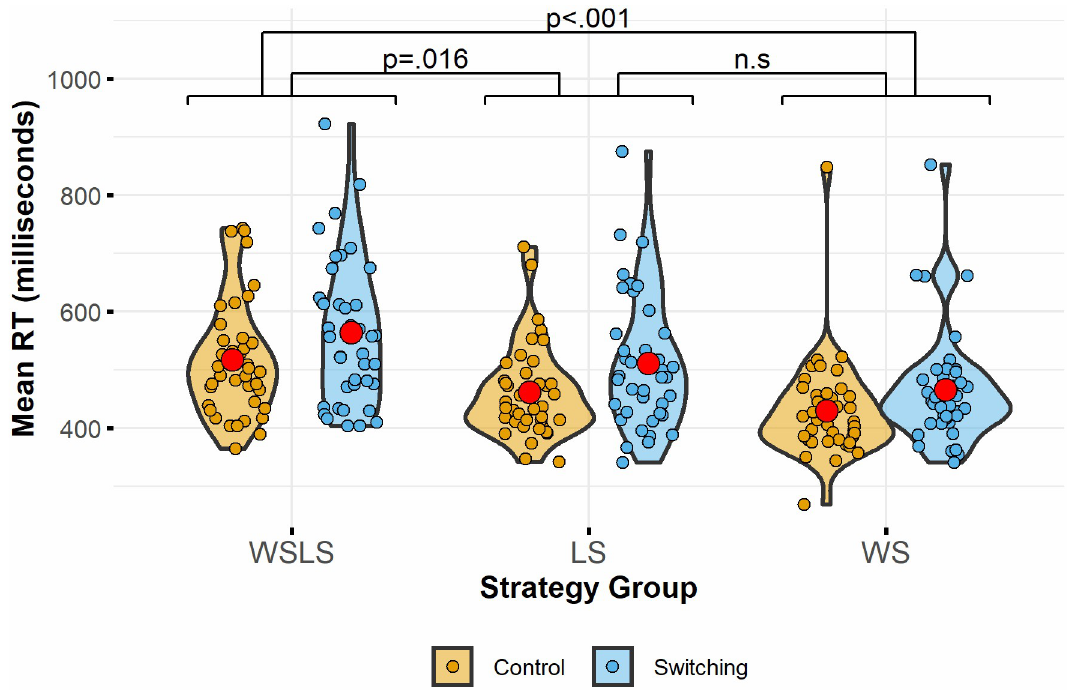
Fig 2. Reaction Times (RT) in the binary choice task for each group and block condition. Red dots indicate the mean in each block. Labelled brackets indicate significance level of comparison between strategy groups overall. The overall reaction time in the selective copy group (WSLS) was significantly slower than both the always copy (WS) and never copy (LS) groups. There was no significant difference overall between the LS and WS groups. The difference between the control and EF block condition was not significantly different for each strategy group.